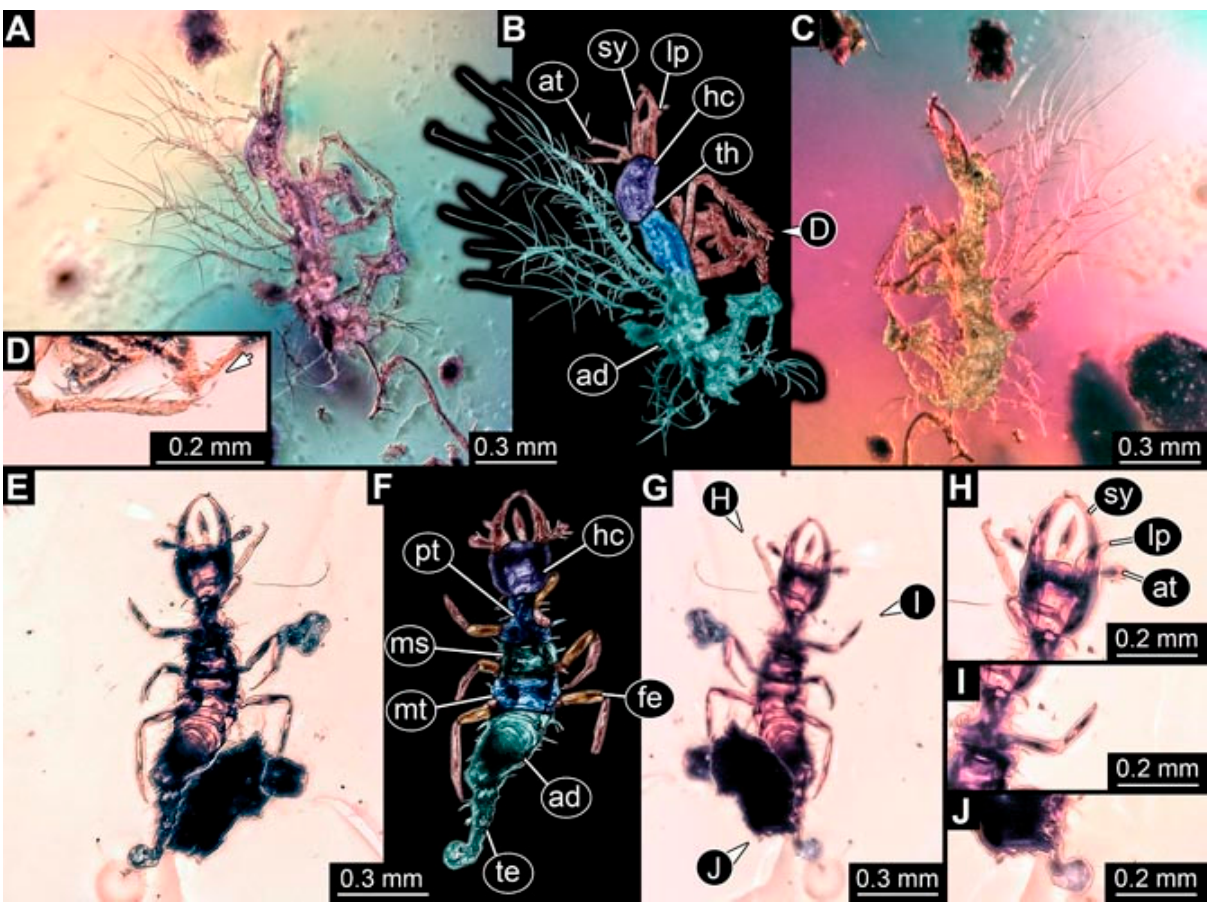
Figure 11. Two specimens in Myanmar amber. ( A – D ) Specimen 4830 (PED 0065). ( A ) Dorso-lateral